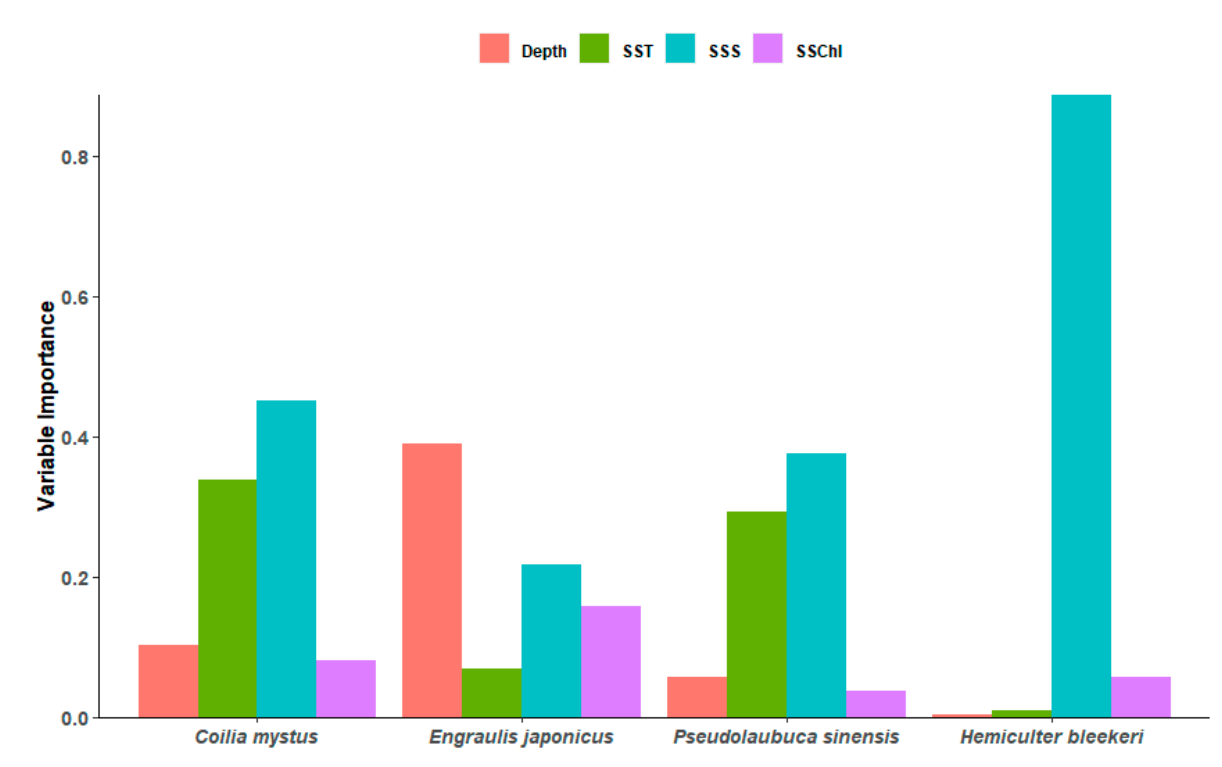
Figure 3. Importance of the four environmental variables (depth (Depth, m), sea surface temperature (SST, °C), sea surface salinity (SSS), and sea surface chlorophyll-a concentration (SSChl, mg/m 3 )) from the ensemble model for the four larval fish species.